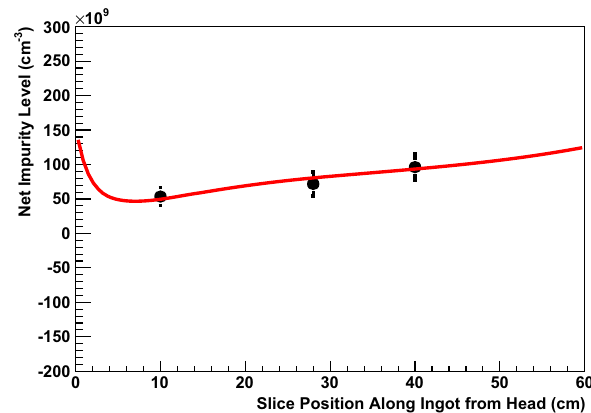
Fig. 3 Shown is a comparison between the experimental data (three dotted points in black) and theoretical prediction (Eq. 9, solid line in